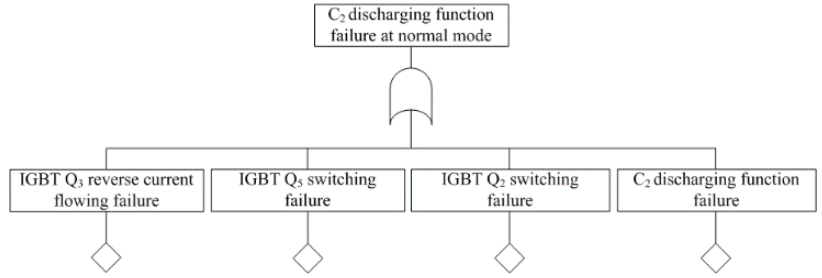
Figure 11. Sub fault tree for C 2 discharging function failure at normal mode.